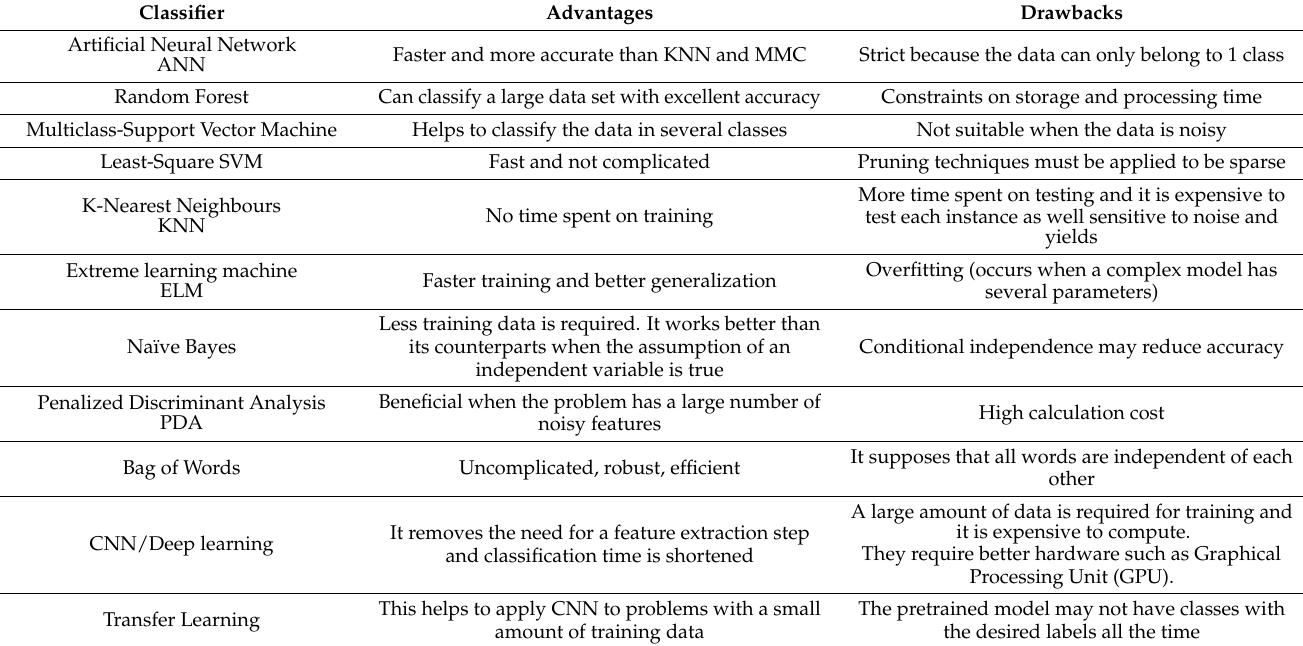
Table 5. Comparison of various